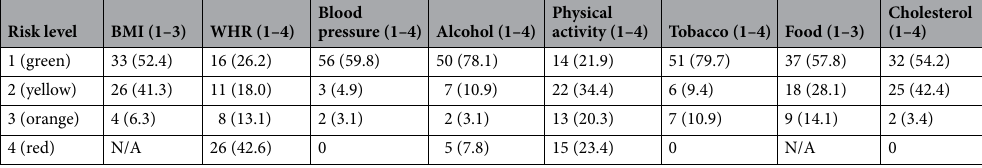
Table 2. Risk levels, N (%), measured with the Health Dialogue at